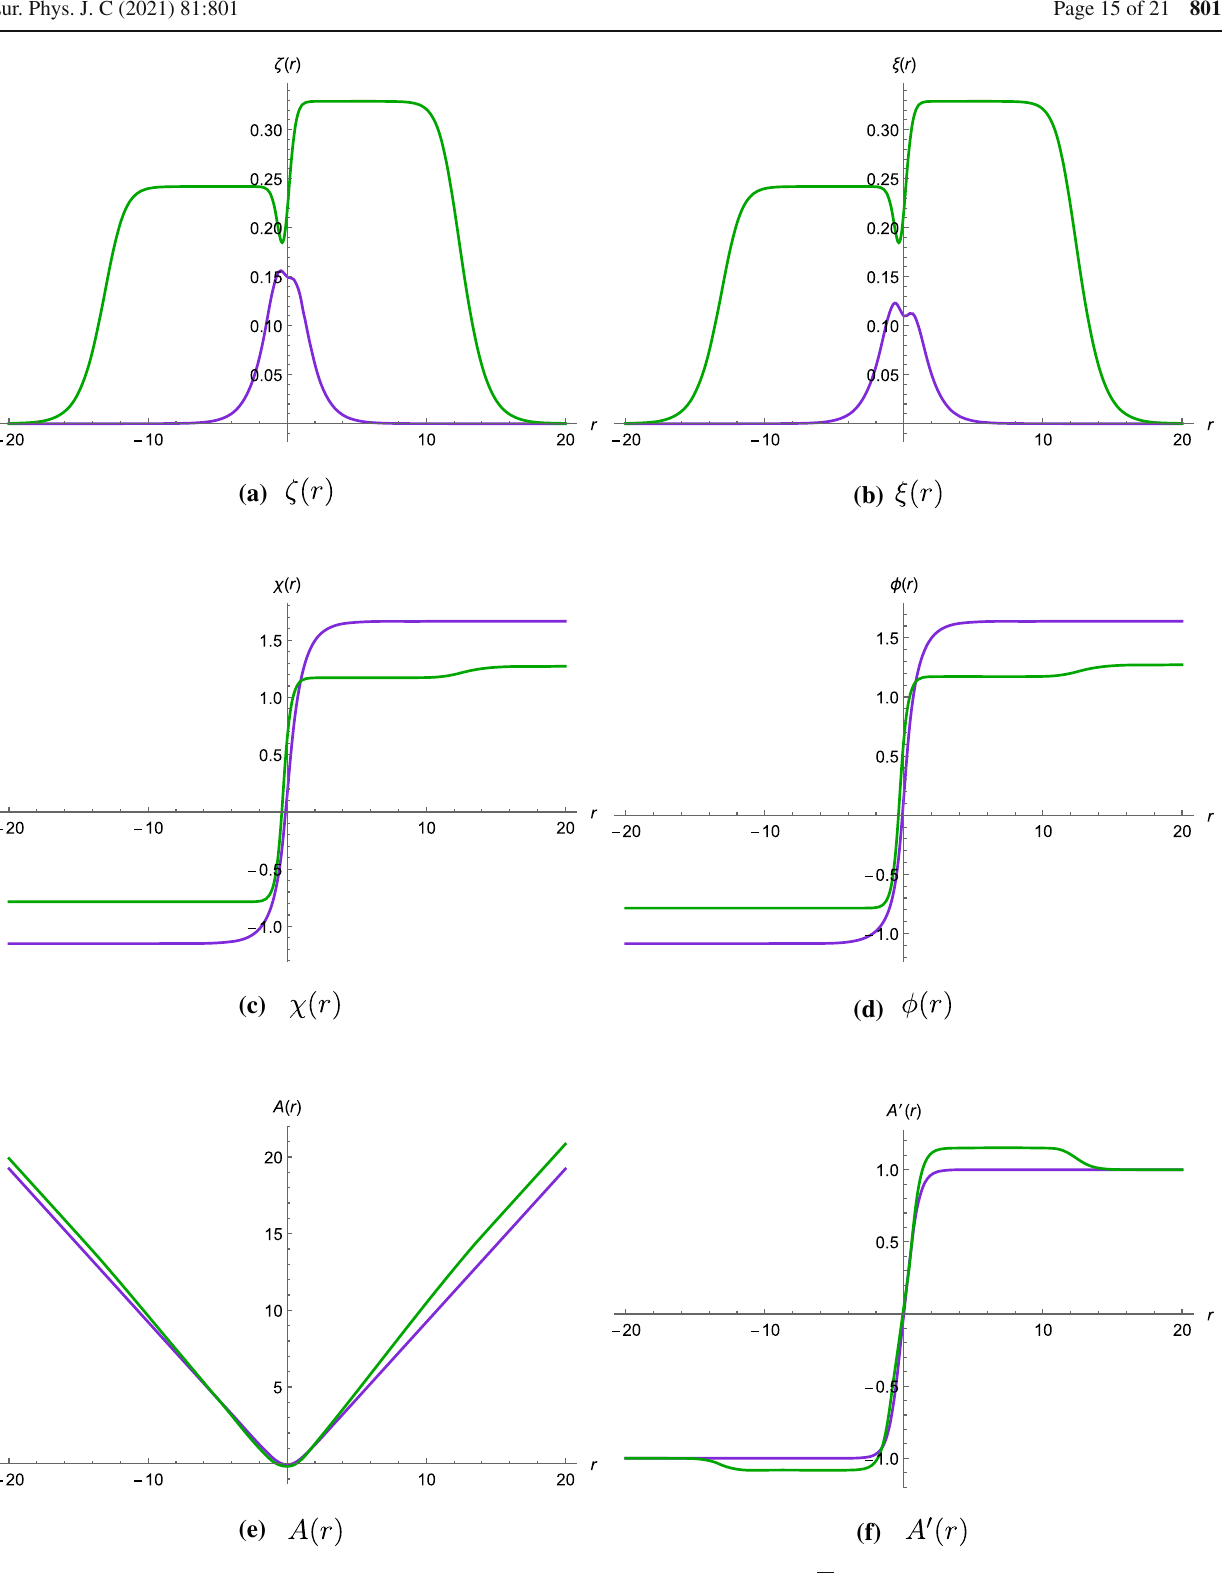
as functions of 8